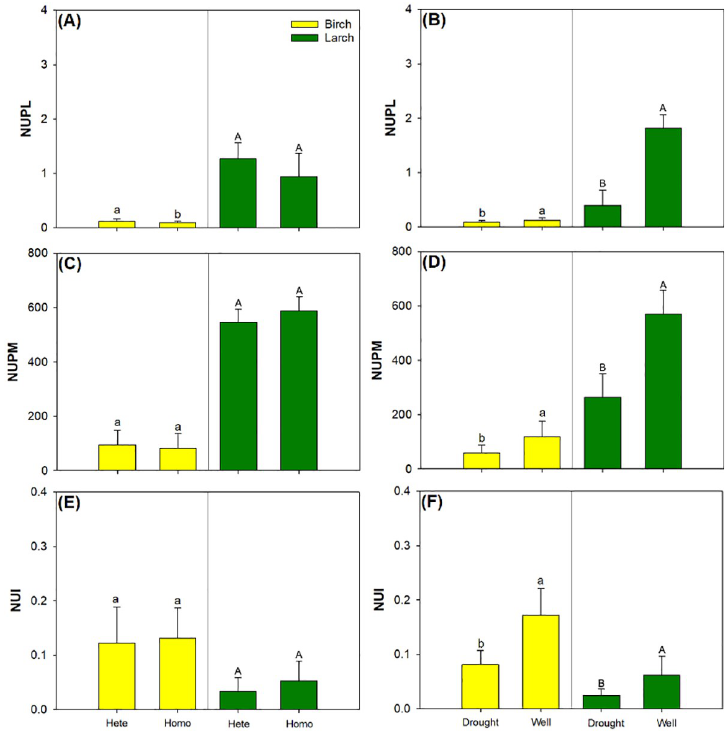
Fig 7. Nutrient uptake per fine root length (NUPL) and per fine root mass (NUPM) and N utilization index (NUI) in birch ( Betula Platyphylla ) and larch ( Larix olgensis ) seedlings subjected to heterogeneous vs homogeneous nutrient patterns in drought or well-watered conditions. Bars indicate standard deviations. Different letters indicate significant difference of raw transformed data (see S1 Table) according to Duncan test at 0.05 level. Lower case letters stand for differences for birch seedlings and capital letters for larch